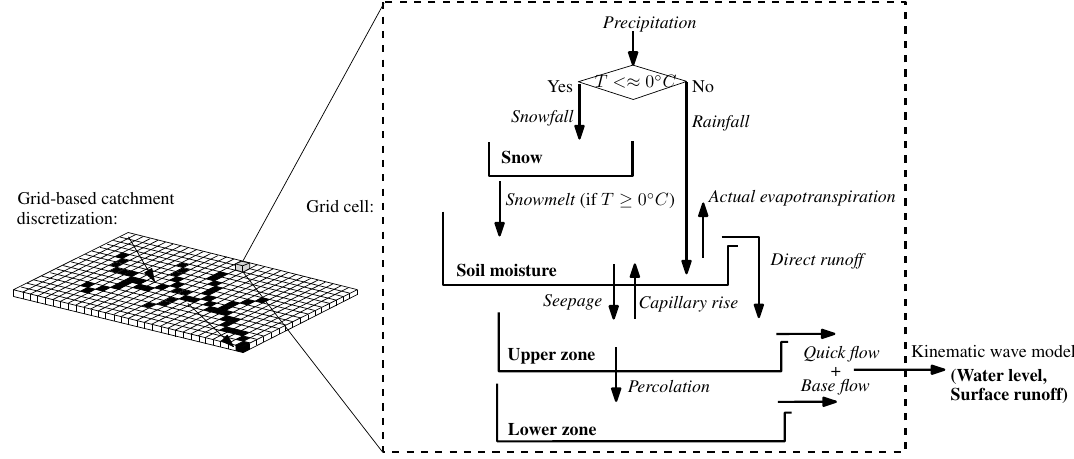
Fig. 2. Left: Catchment discretisation using a grid-based approach including the channel delineation. Arrows indicate flow direction. Right: Schematic structure of the HBV-96 model for each grid cell. Model states are in bold and model fluxes in italics.